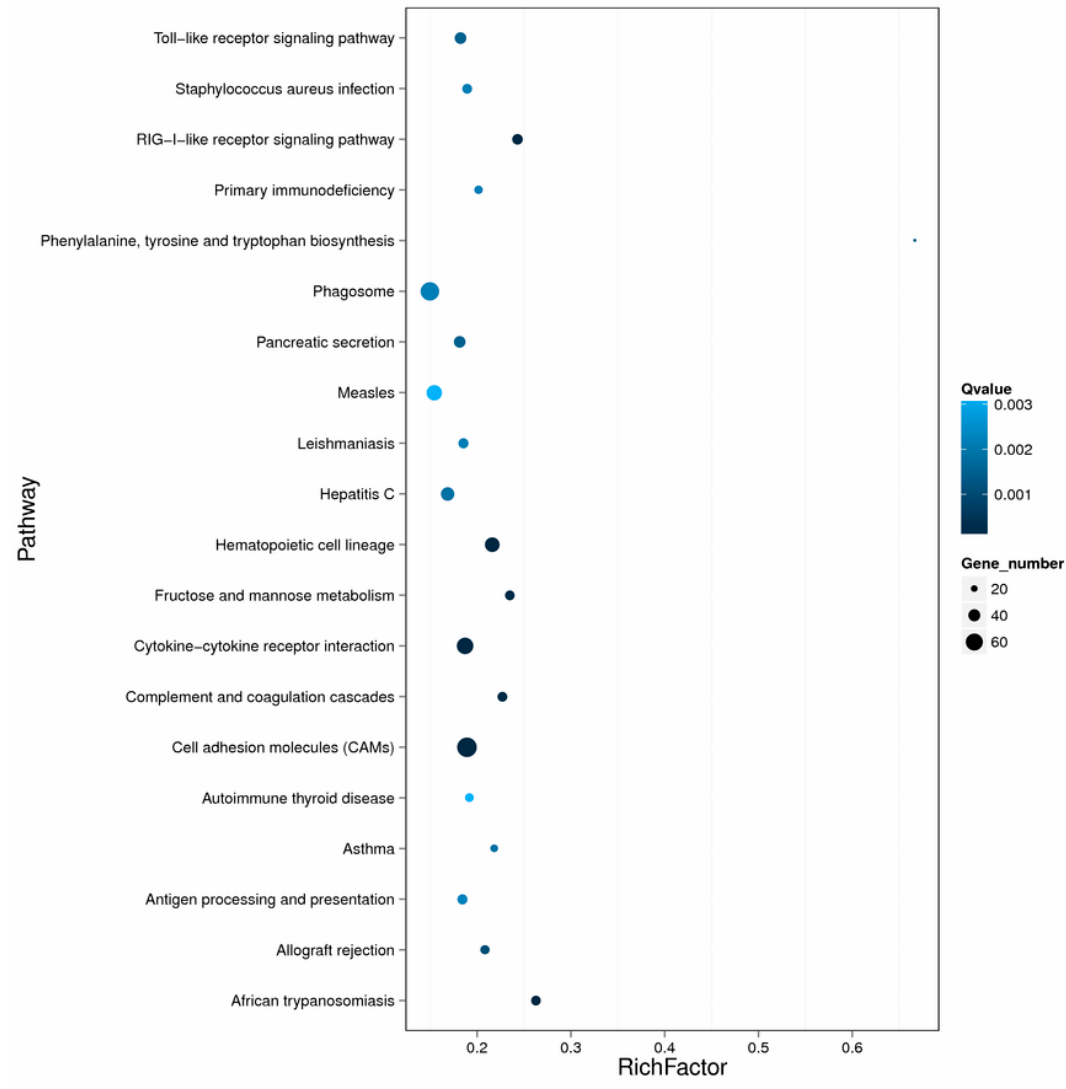
Figure 4. Scatterplot of the top 20 enriched KEGG pathways. Rich Factor is the ratio of differentially expressed gene numbers annotated in this pathway terms to all gene numbers annotated in this pathway term. q ≤ 0.05 as significantly enriched.